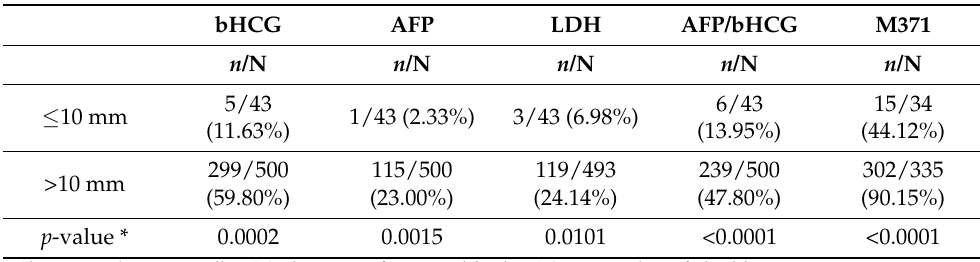
Table 11. Serum tumour marker expression rates stratified by tumour size categories only in patients with germ cell tumours (SE, NS). bHCG AFP LDH AFP/bHCG